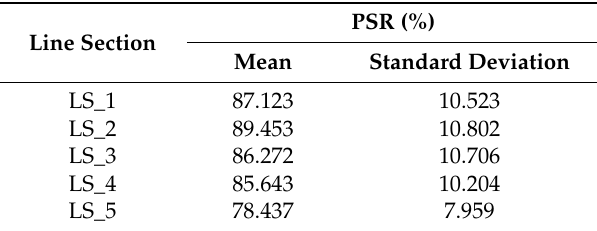
Table 5. PSR results for the FMS.